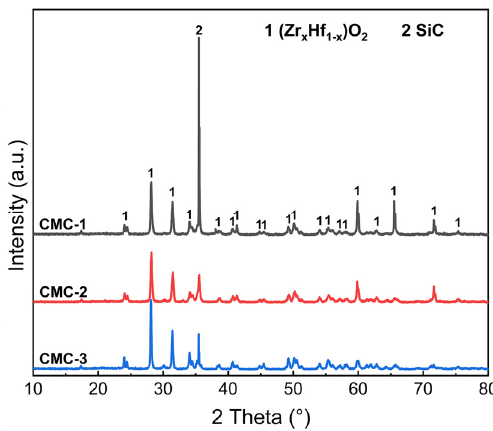
Figure 7. XRD patterns of the C/C-SiC-(Zr x Hf 1 − x )C composites after ablation.